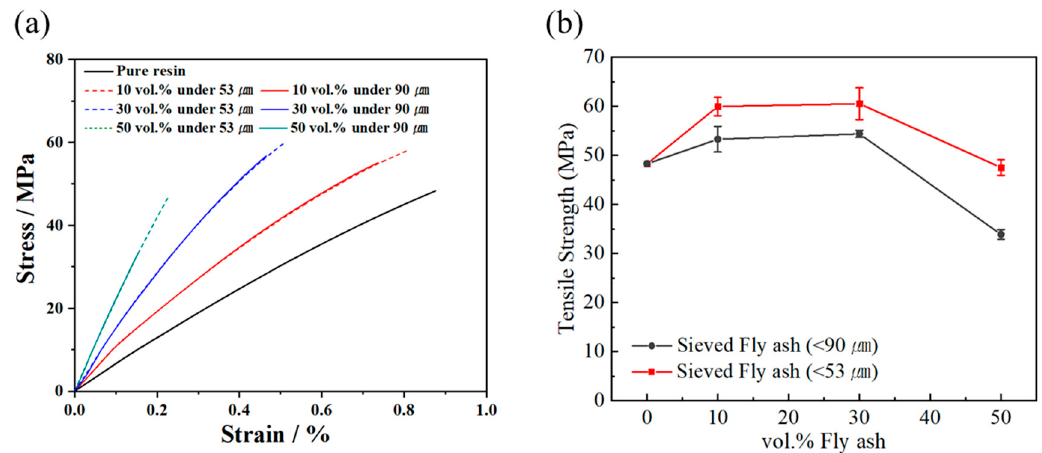
Figure 6. ( a ) Tensile stress–strain curves of composite containing less than 90 µ m, 53 µ m fly ash, ( b ) Tensile strength of the fly ash/epoxy composite.